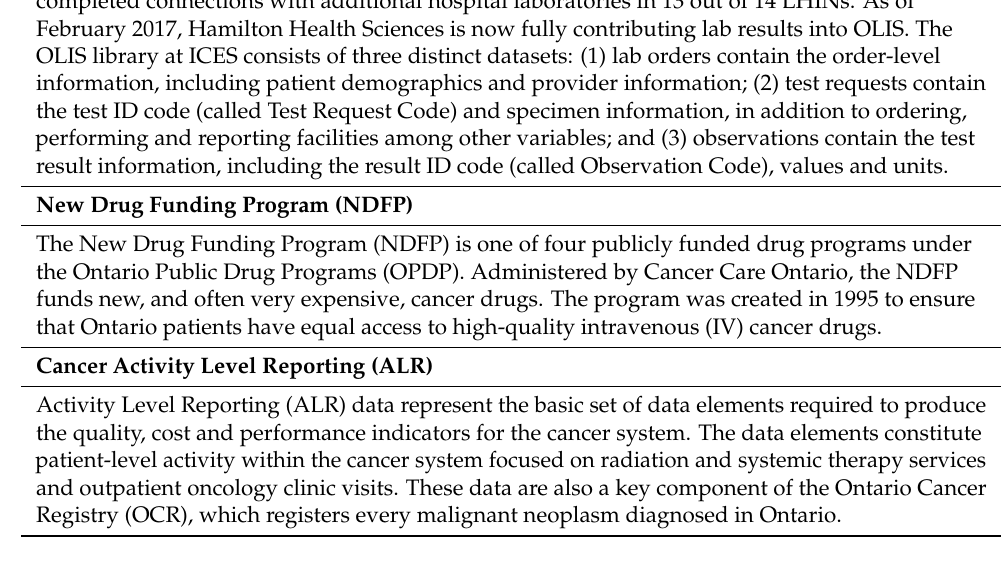
Table A2. Definition of variables to describe baseline